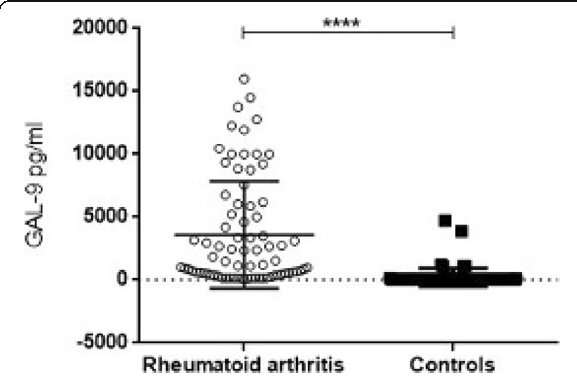
Fig. 1 (abstract P415). GAL-9 levels in Rheumatoid arthritis patients and